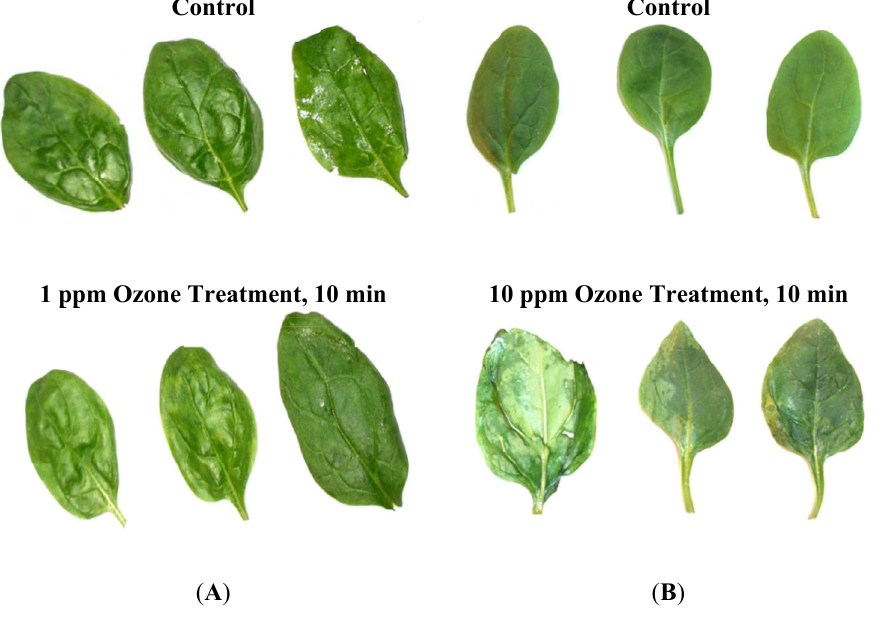
Figure 2. ( A ) Impact of ozone exposure levels on visual quality of spinach when treated at 1 ppm ozone concentration for 10 min and ( B ) Ozone injury/visual damage on spinach when exposed to 10 ppm ozone concentration for 10